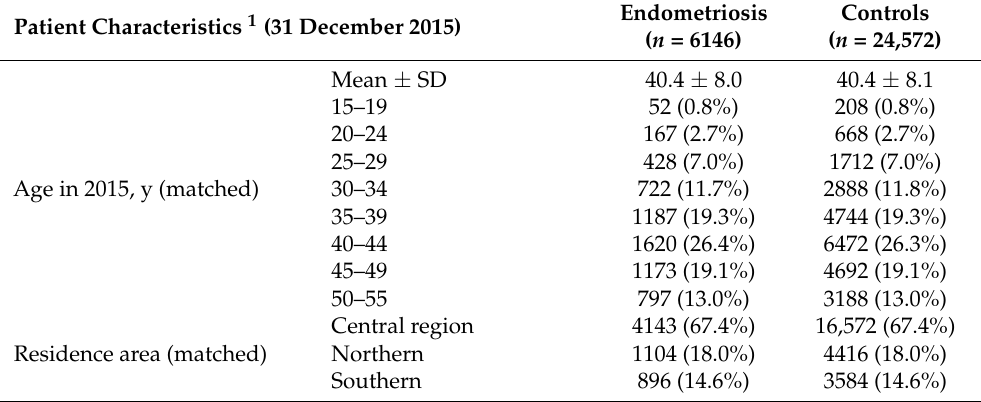
Table 1. Sociodemographic characteristics and BMI of women diagnosed with endometriosis com- pared to matched